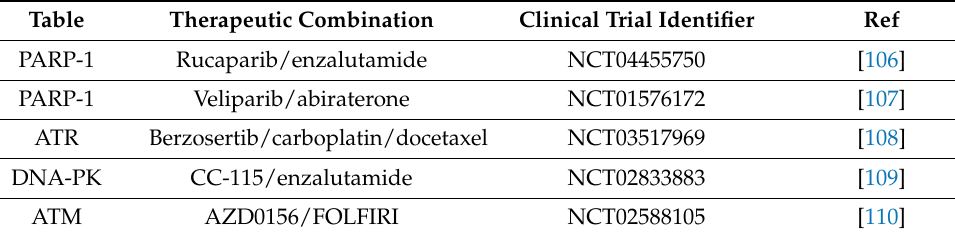
Table 2. Examples of (DNA damage response) DDR synthetic lethality in PCa. TFs in clinical practice from a treatment perspective. Stratification of patients in clinical trials aligns to treatment and relies mostly on mutational classifiers rather than activity signatures. TFs such as MYC, TP53, ATM, ATR, PARP1, BRACA1/2, DNA-PK, and GATA2 have been targeted through rucaparib (PARP1- rucaparib/enzalutamide/abiraterone), berzosertib (ATR-berzosertib/carboplatin/docetaxel) and CC-115 (DNA-PK; CC-115/enzalutamide) in current clinical trials [105]. Table Therapeutic Combination Clinical Trial Identifier Ref